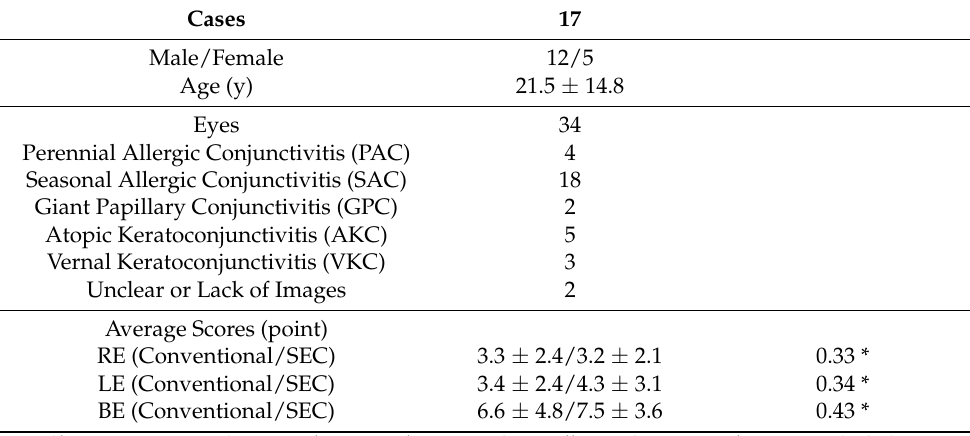
Table 1. Demographics of the